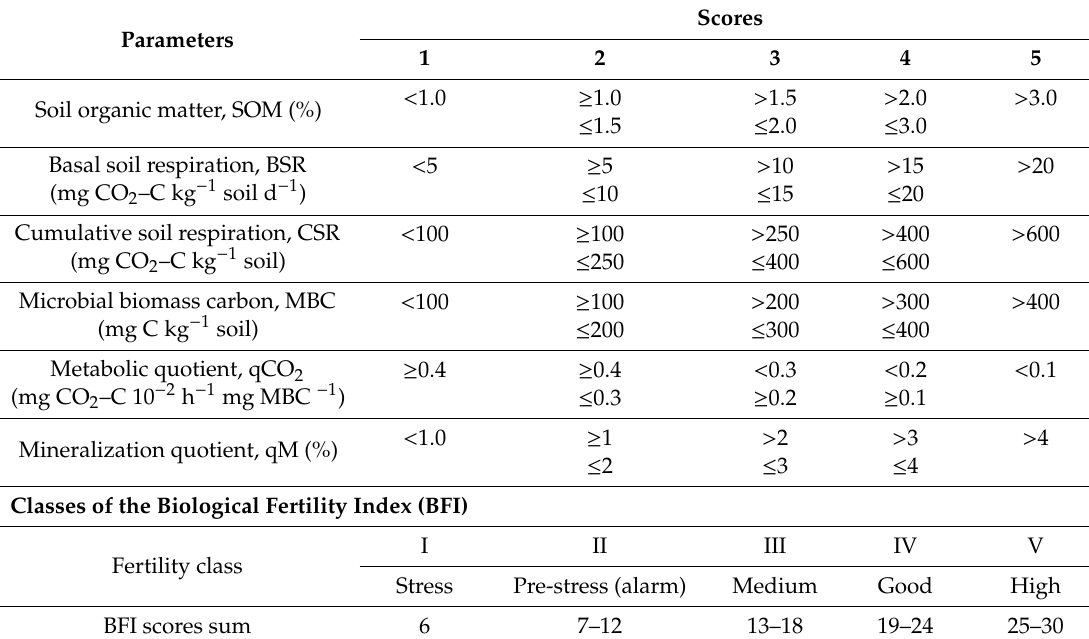
Table 2. Scores of the intervals of values for the di ff erent